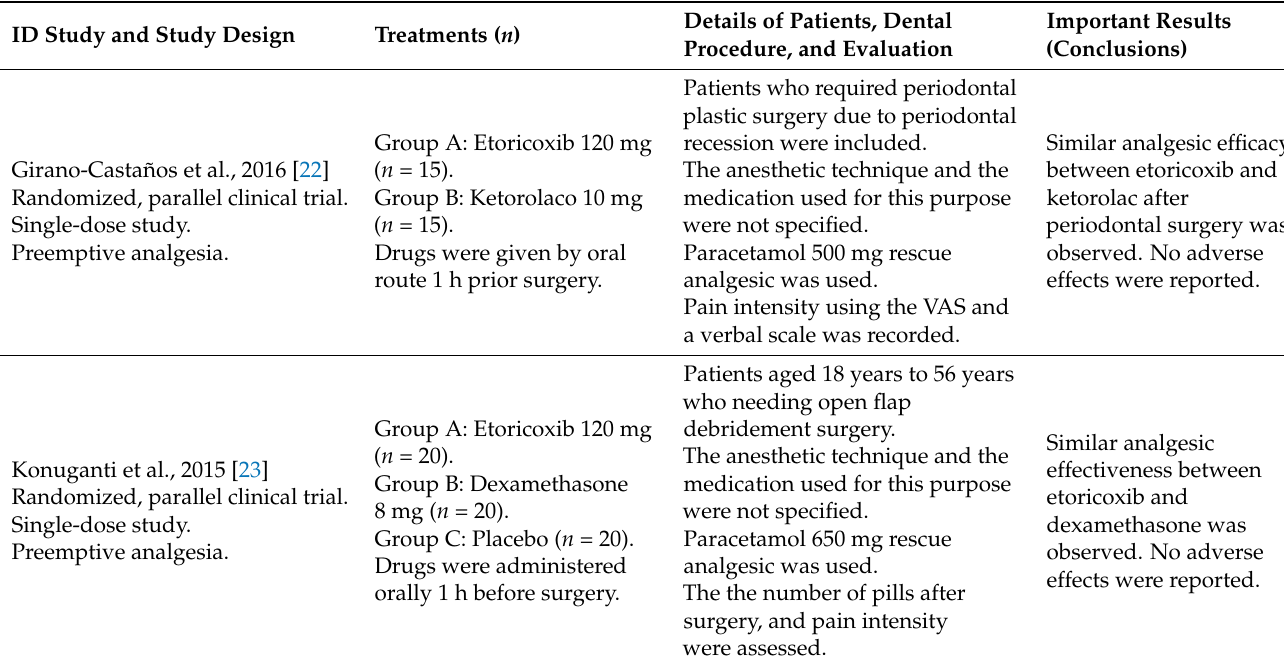
Table 2. Characteristics of the excluded